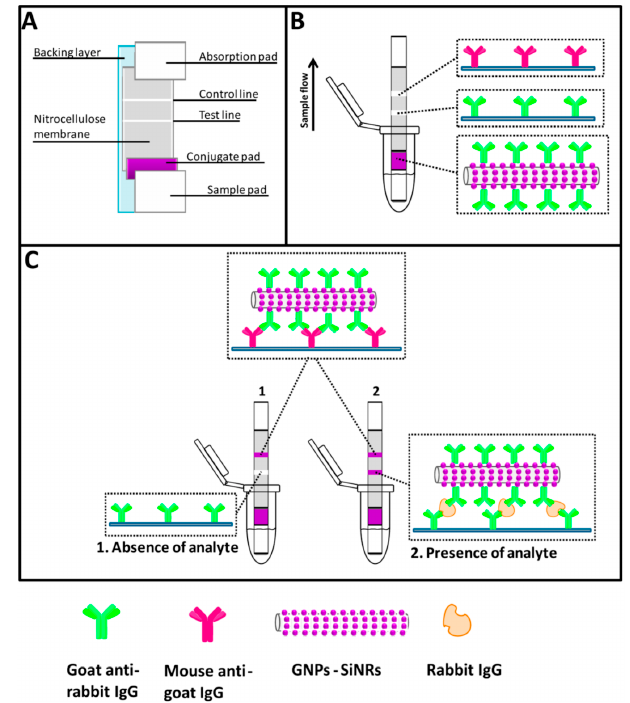
Figure 4. Lateral-flow strip biosensor described by Xu et al. ( A ) scheme of the device, ( B ) position of immobilized reagent on the strip and ( C ) measurement principle of the lateral-flow strip biosensor based on gold-nanoparticle-decorated silica nanorod (GNPSiNR) label in the presence and absence of rabbit IgG. Modified with permission from [68].